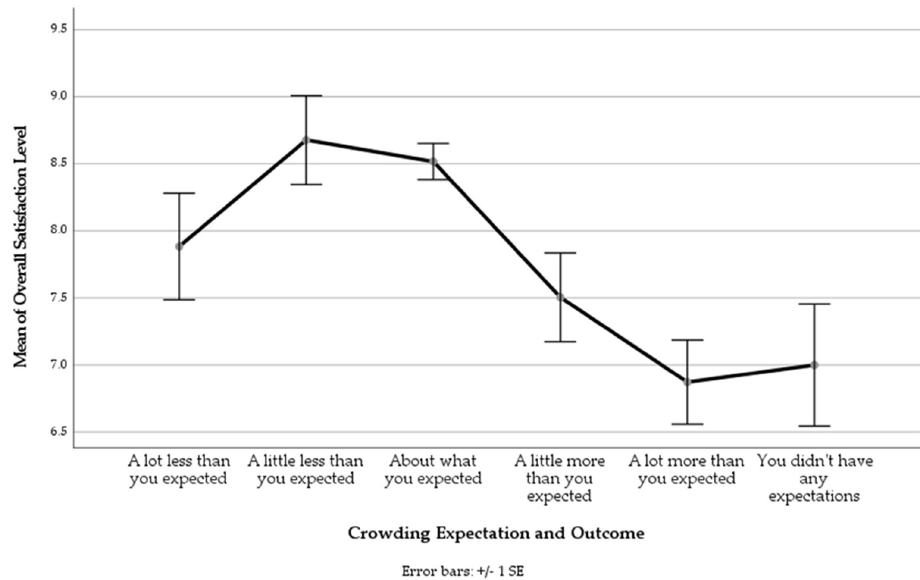
Figure 4. Means plot of ANOVA between satisfaction and crowding expectation/outcome with standard error bars.